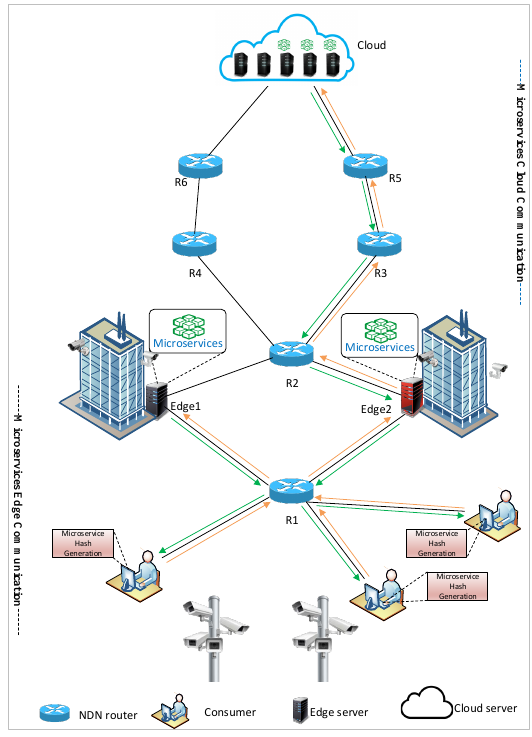
Figure 2. Proposed scheme